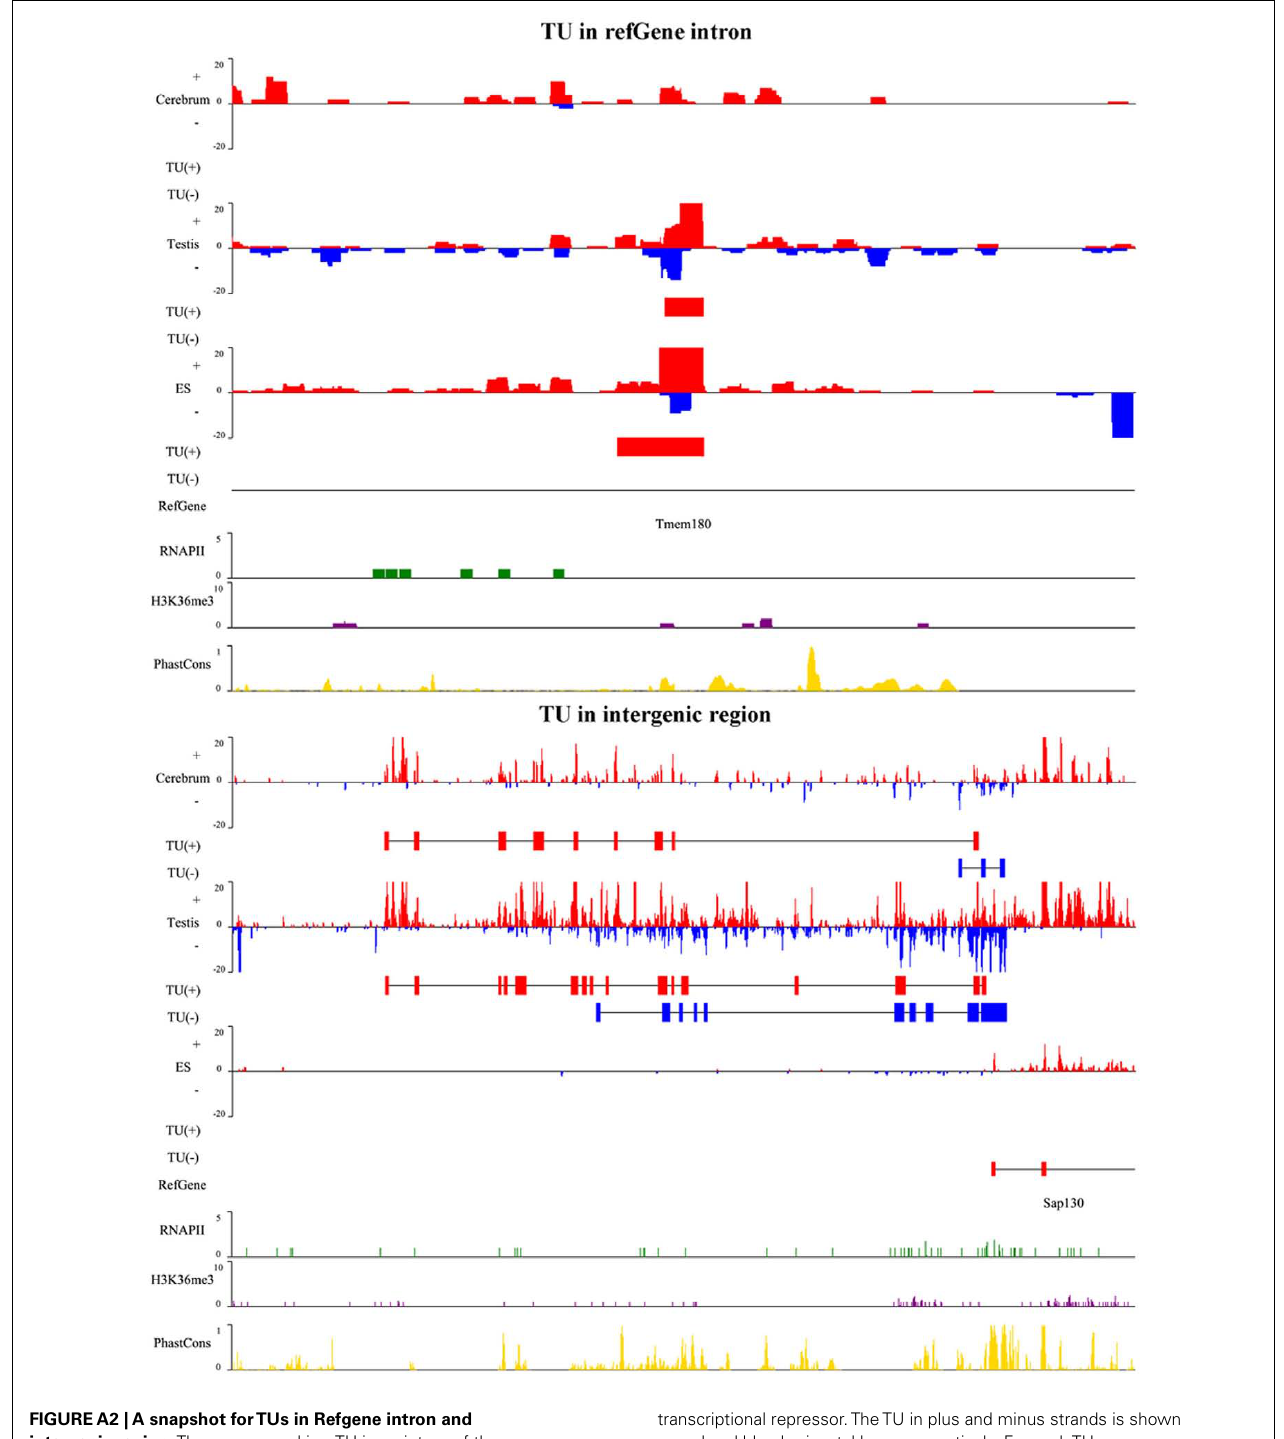
FIGUREA2 |A snapshot forTUs in Refgene intron and intergenic region. The upper panel is aTU in an intron of the transmembrane protein gene,Tmem180, and lower panel is aTU adjacent to Sap130 gene. SAP130 is a subunit of the histone deacetylase-dependent SIN3A co-repressor complex which acts as a